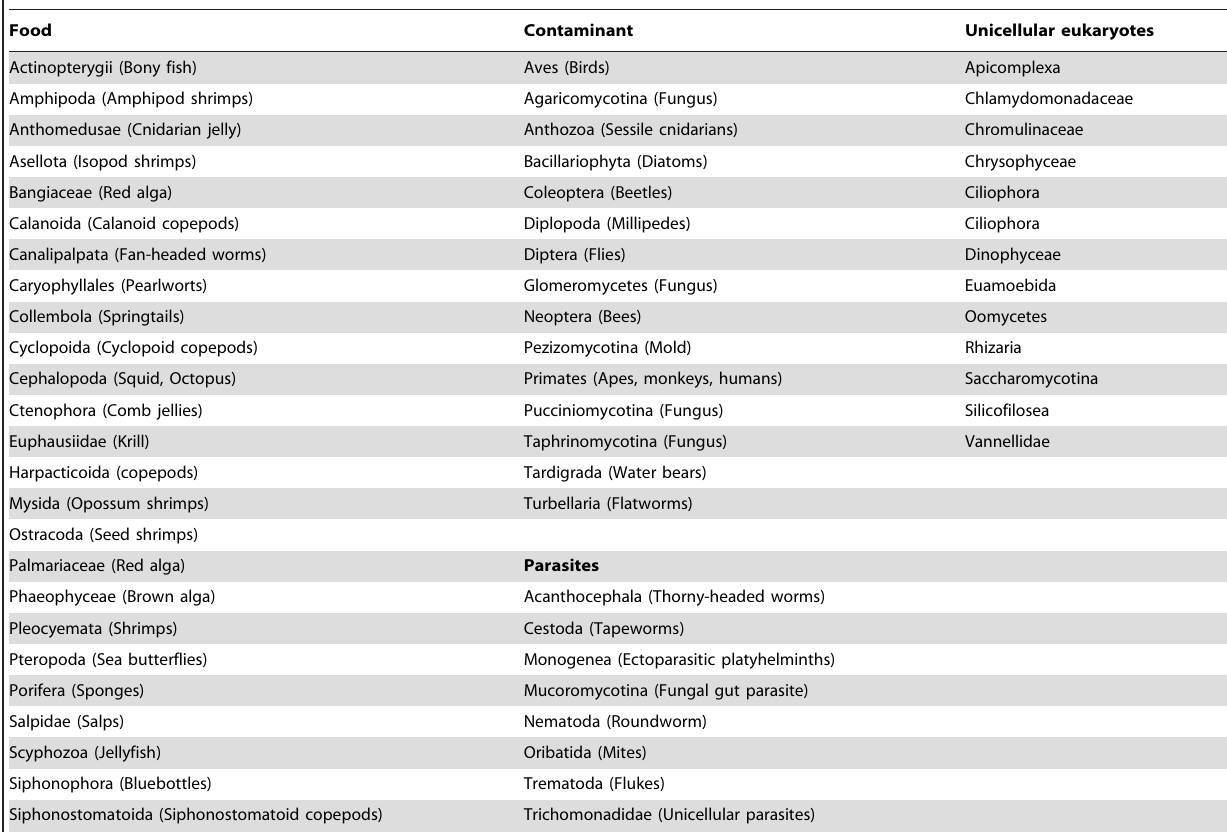
Table 3. Categories and taxa for sequence